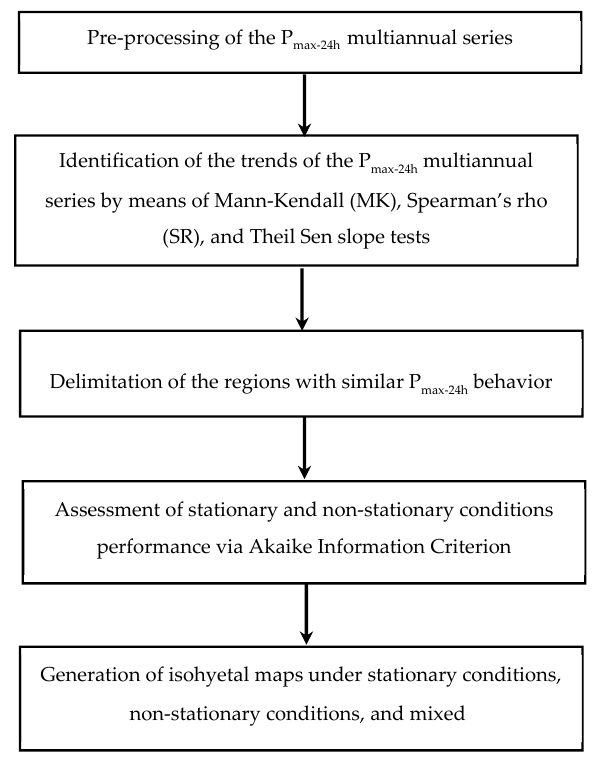
Figure 2. Research methodology flowchart.